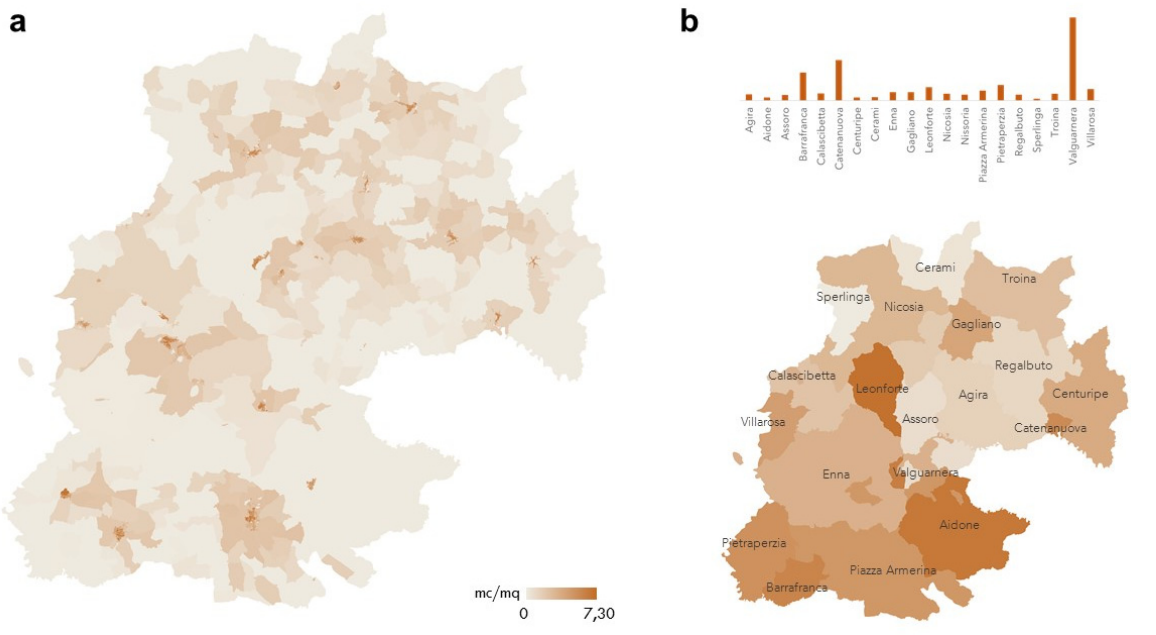
Figure 14. Building density index on the double scale of the Census Sections ( a ) and Municipalities ( b ) (numerical values under the colour ramp).